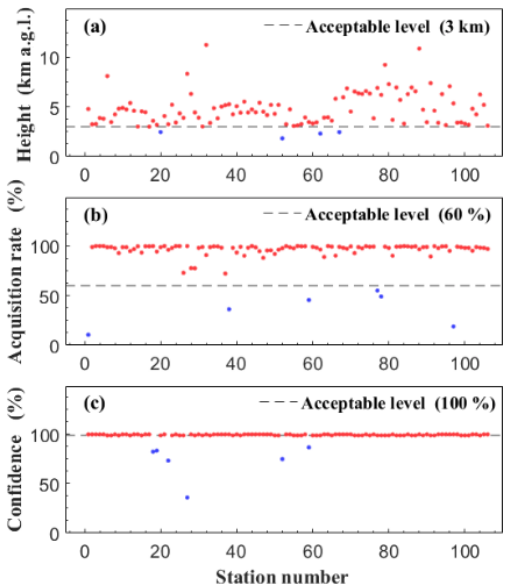
Figure 5. Recommended (red dots) and non-recommended sites (blue dots) of the radar wind profiler network by different perfor- mance metrics: (a) effective height detected by RWP, (c) data ac- quisition rate and (e) data confidence. The horizontal grey lines in- dicate their corresponding acceptable threshold levels.